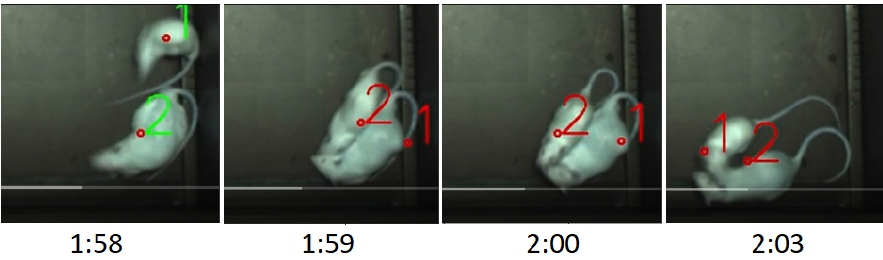
Figure 4. Some examples for frames selected from a demonstration video attached to [21] where ID tracking fails. The numbers 1 and 2 correspond to instance IDs. During episodes of significant overlaps multiple ID changes